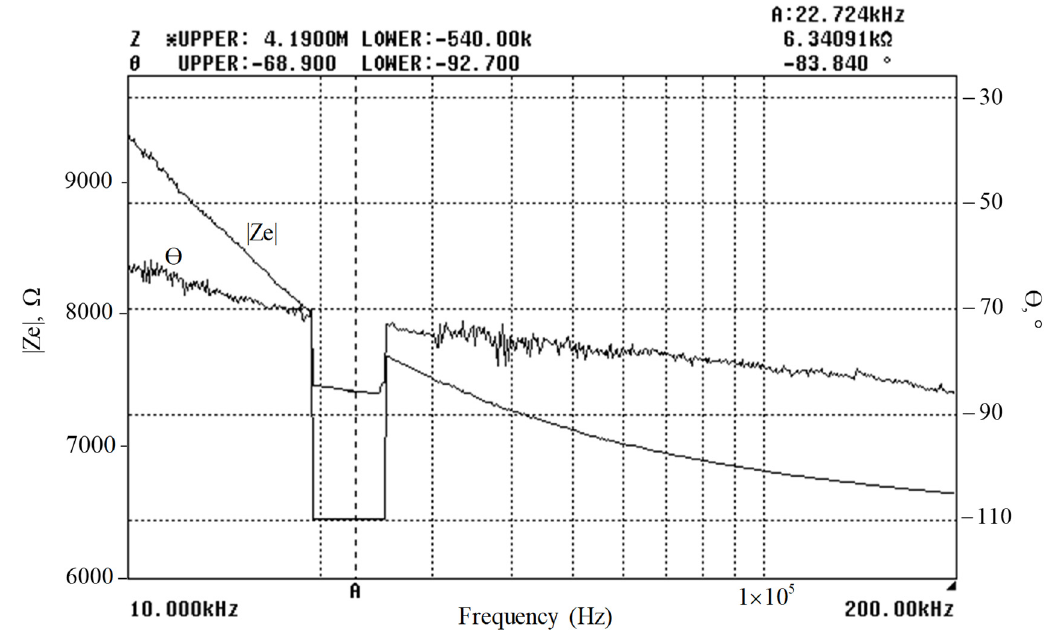
Figure 5. Impedance Z and phase angle θ against frequency for a sample Si/Al/KNbO 3 /Al with thin potassium niobate (KNbO 3 ) film.